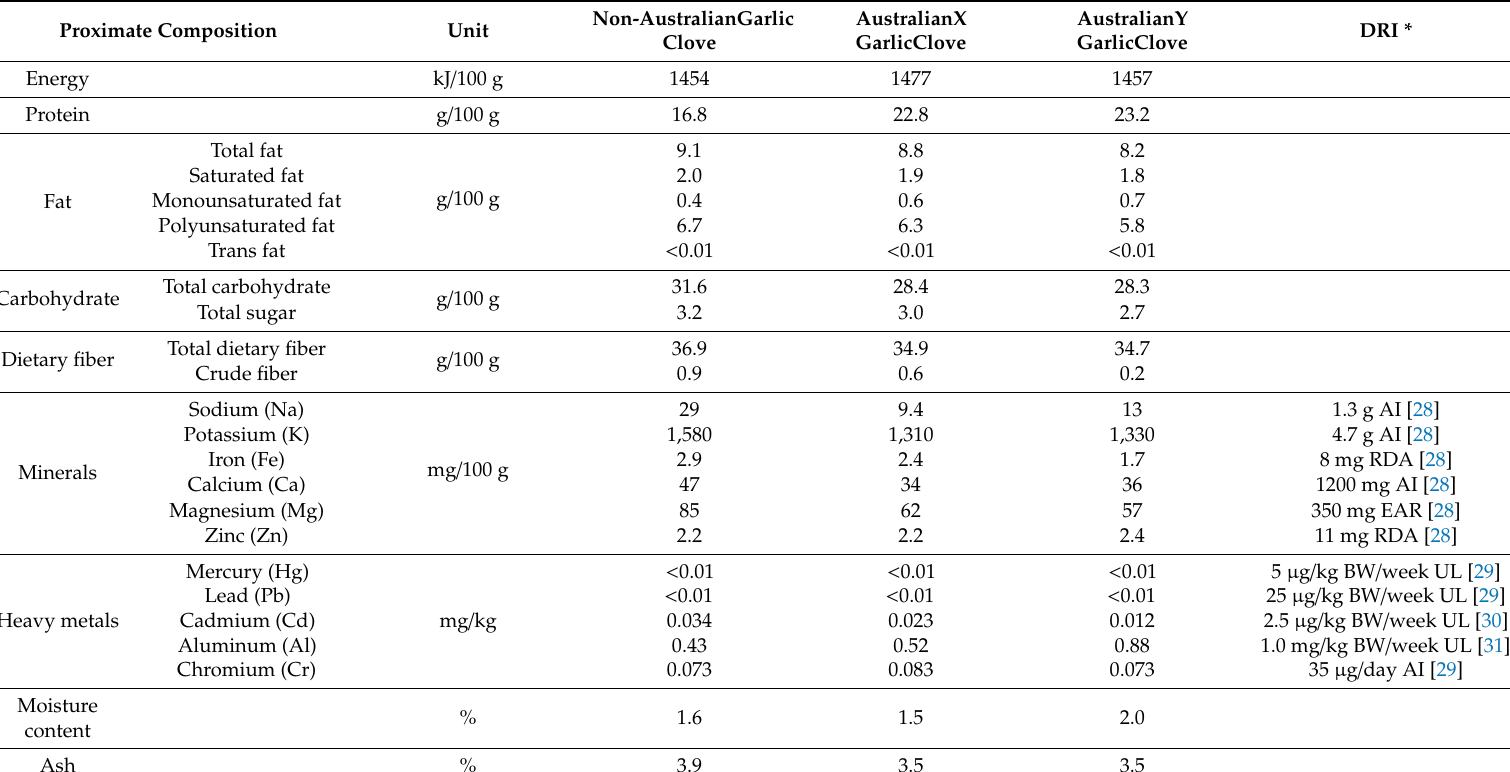
Table 1. Proximate analysis, minerals, and heavy metals of edible garlic